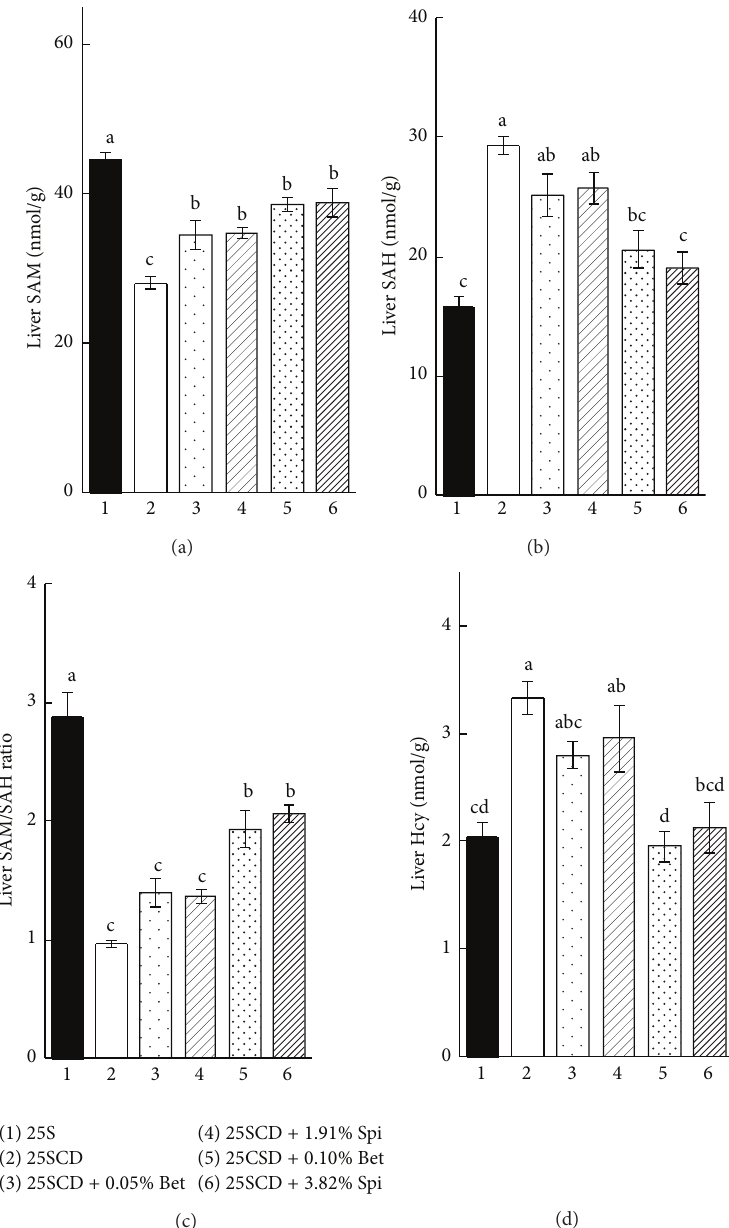
Figure 6: Hepatic concentrations of S-adenosylmethionine (a) and S-adenosylhomocysteine (b), their ratio (c), and homocysteine (d) in rats fed the experimental diets (experiment 2). Each value is the mean ± SEM, 𝑛 = 6 . Values in a panel without a common letter differ at 𝑃 < 0.05 .